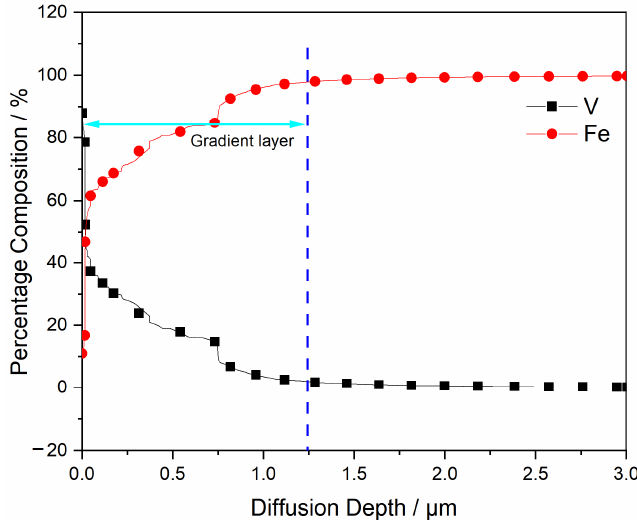
Figure 8. Distribution of Fe and V content of specimen sections at 250 mA·cm −2 . Light blue line is gradual range of vanadium deposition and dark blue line is the proportion of vanadium is re- duced to 2.0 %.